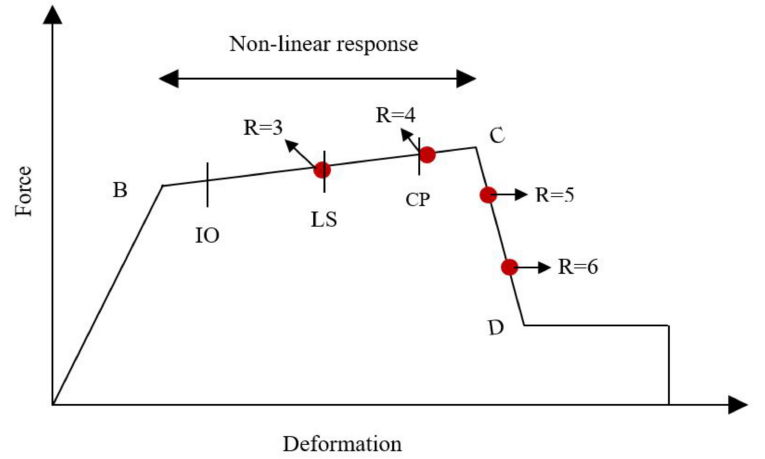
Figure 11. Schematic representation of variation in the building performance level with respect to R factors at the MCE design level under bidirectional